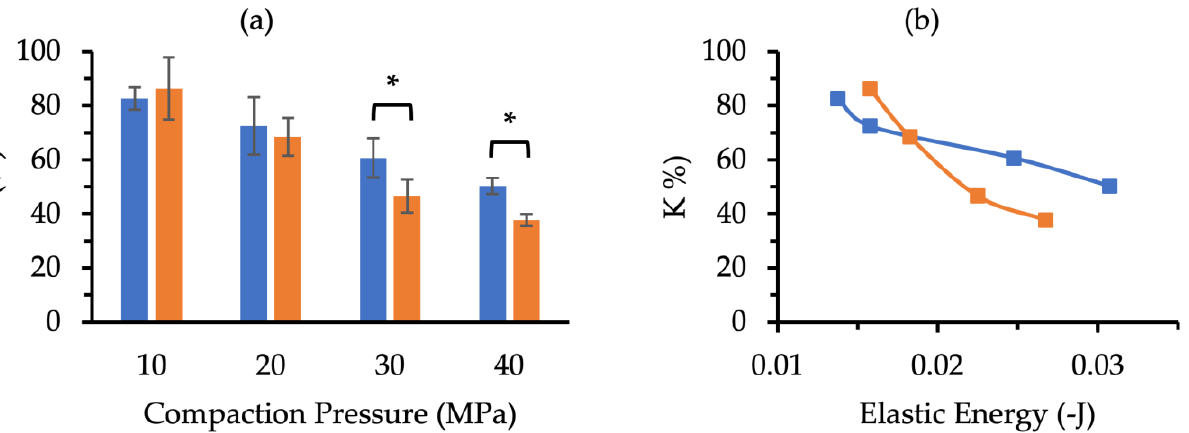
Figure 7. ( a ) K values of MCC ( ) and XPVP ( ) pellets tableted at various compaction pressures ( n = 4). Error bars represent the standard deviation and * denotes a significant ( p < 0.05) difference. ( b ) Plot of K values over tablet elastic energy where error bars were omitted for clarity ( n = 4).